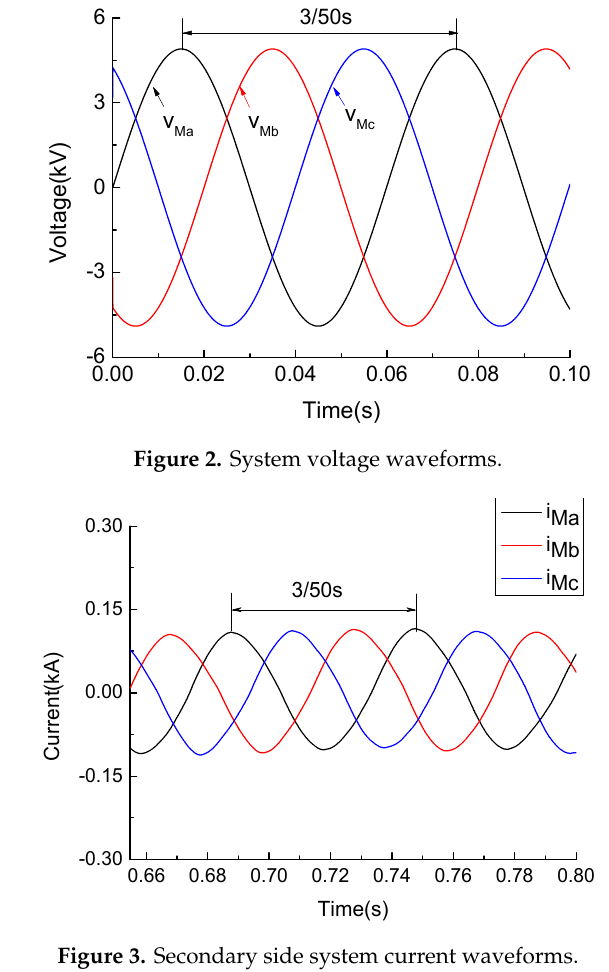
Figure 3. Secondary side system current waveforms.